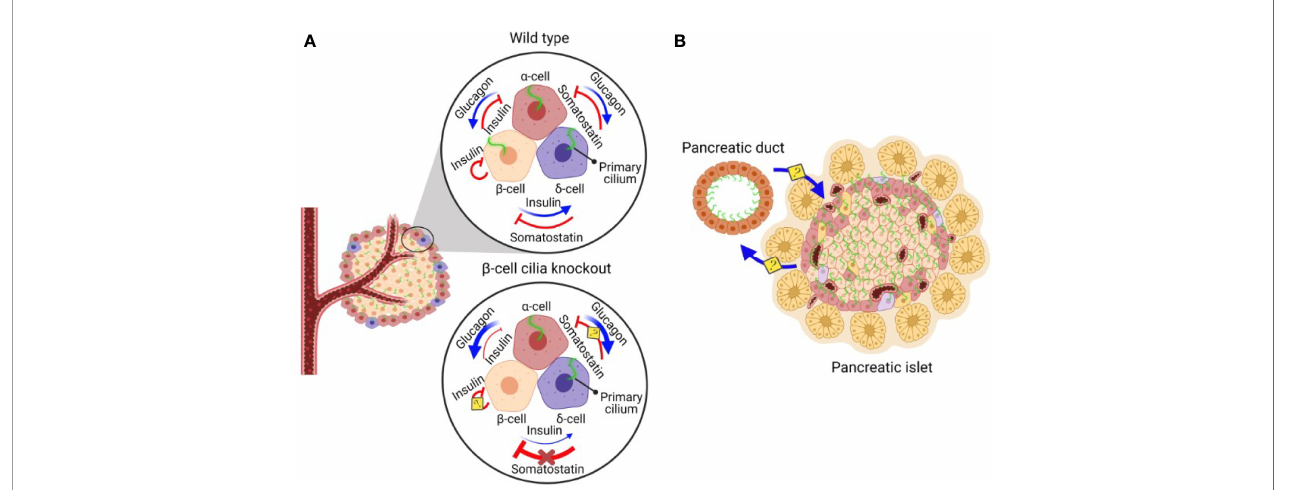
FIGURE 1 | A schematic diagram of b -cell cilia-modulated islet hormone regulation and putative reciprocal communication between pancreatic ductal and islet cilia. (A) In normal pancreatic islets, a -cells secrete glucagon, stimulating insulin and somatostatin secretion. b -cells secrete insulin, inhibiting glucagon secretion and stimulating somatostatin secretion. d -cells secrete somatostatin, inhibiting both glucagon and insulin secretion (73). In pancreatic islets without b -cell cilia, the ability of b -cells to regulate a - and d -cells via insulin secretion is disrupted, leading to dysregulated hormone secretion from a - and d -cells. Inhibitory somatostatin effects on b -cells are lost in the absence of b -cell cilia, leading to somatostatin insensitivity and driving compensatory increases in somatostatin secretion by d -cells (18). The role of cilia in insulin-mediated inhibitory autocrine signalling and somatostatin-inhibited glucagon secretion await clari fi cation using cell-speci fi c cilia deletion models. (B) Pancreatic ducts are ciliated and in close proximity to the cilia on pancreatic islet cells, raising the possibility that pancreatic ductal cilia may reciprocally communicate with islet cell cilia to regulate differentiation, proliferation, and function of the pancreatic endocrine and exocrine